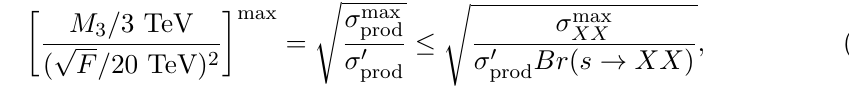
Figure 7. Resonant di-Higgs production cross section of the process pp p S = 14 TeV. The model parameters are chosen as m p F = 20 TeV, K p = 2, K d = 1 :